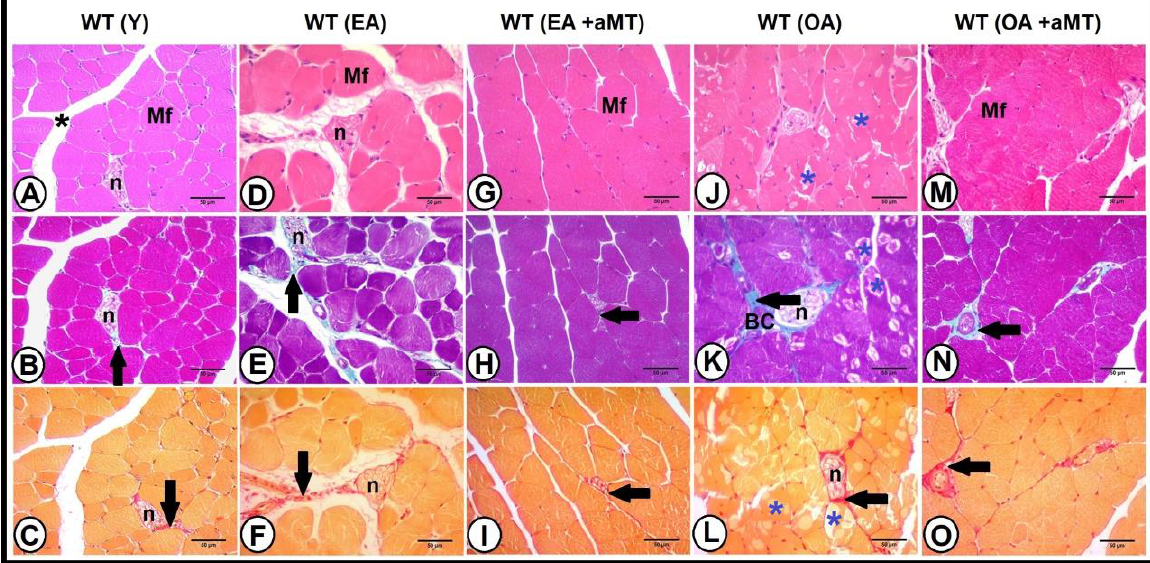
Figure 5. Age-associated changes in the gastrocnemius muscle architecture and the protective effect of melatonin. Photomicrographs of cross section of the gastrocnemius muscles of the young (Y), early aged (EA), early aged with melatonin (EA + aMT), old-aged (OA), and old-aged with melatonin (OA + aMT) WT mice stained with H&E ( A , D , G , J , M ); Crossmon’s trichrome ( B , E , H , K , N ), and Van Gieson ( C , F , I , L , O ) stains. ( A – C ) Photomicrographs of the Y mice showing arrangement of muscle fibers in bundles, which are separated by interstitial space (black asterisk) that contains collagenous tissue (arrows) and nerve fibers (n). ( D – F ) Photomicrographs of the EA animals revealing widening of interstitial spaces with increased collagenous tissues deposition (arrows). ( G – I ) Photomicrographs of the EA animals after melatonin supplementation exhibiting the protective effect of melatonin on reducing muscular interstitial spaces and minimizing collagen deposition (arrows). ( J – L ) Photomicrographs of the OA mice illustrating an excessive accumulation of the collagen fibers (arrows) in interstitial spaces around nerves (n) and blood capillaries (BC). Note, presence of necrotic areas (blue asterisk) within muscle fibers of the OA animals. ( M – O ) Photomicrographs of OA mice with melatonin treatment depicting the beneficial effect of melatonin on conserving the architecture of muscle fibers (Mf) and reducing collagenous tissue deposition (arrows). Bar = 50 μm.